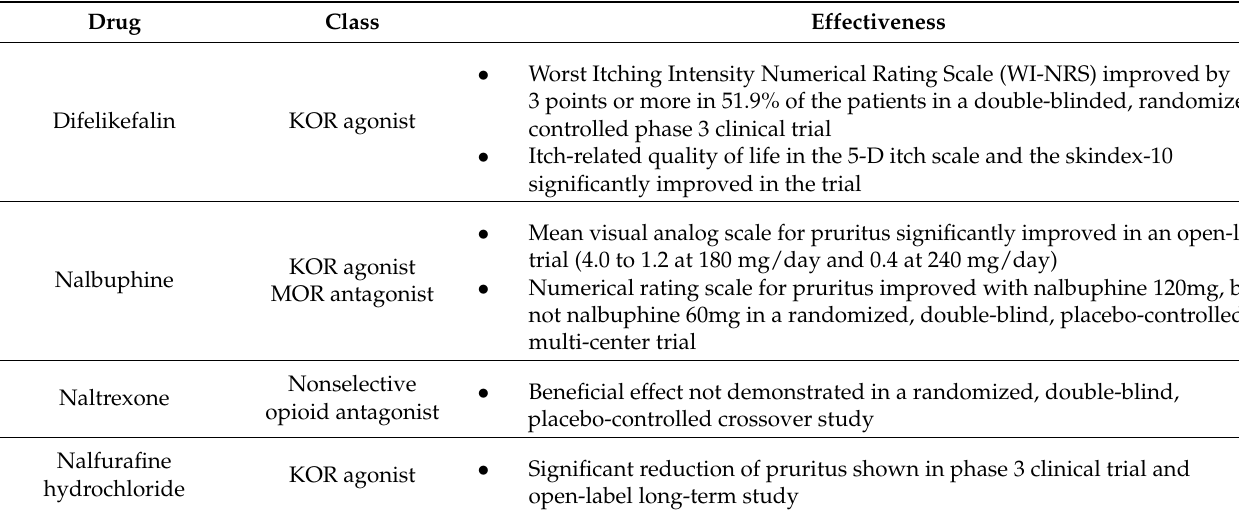
Table 2. Effectiveness of opioid agonists and